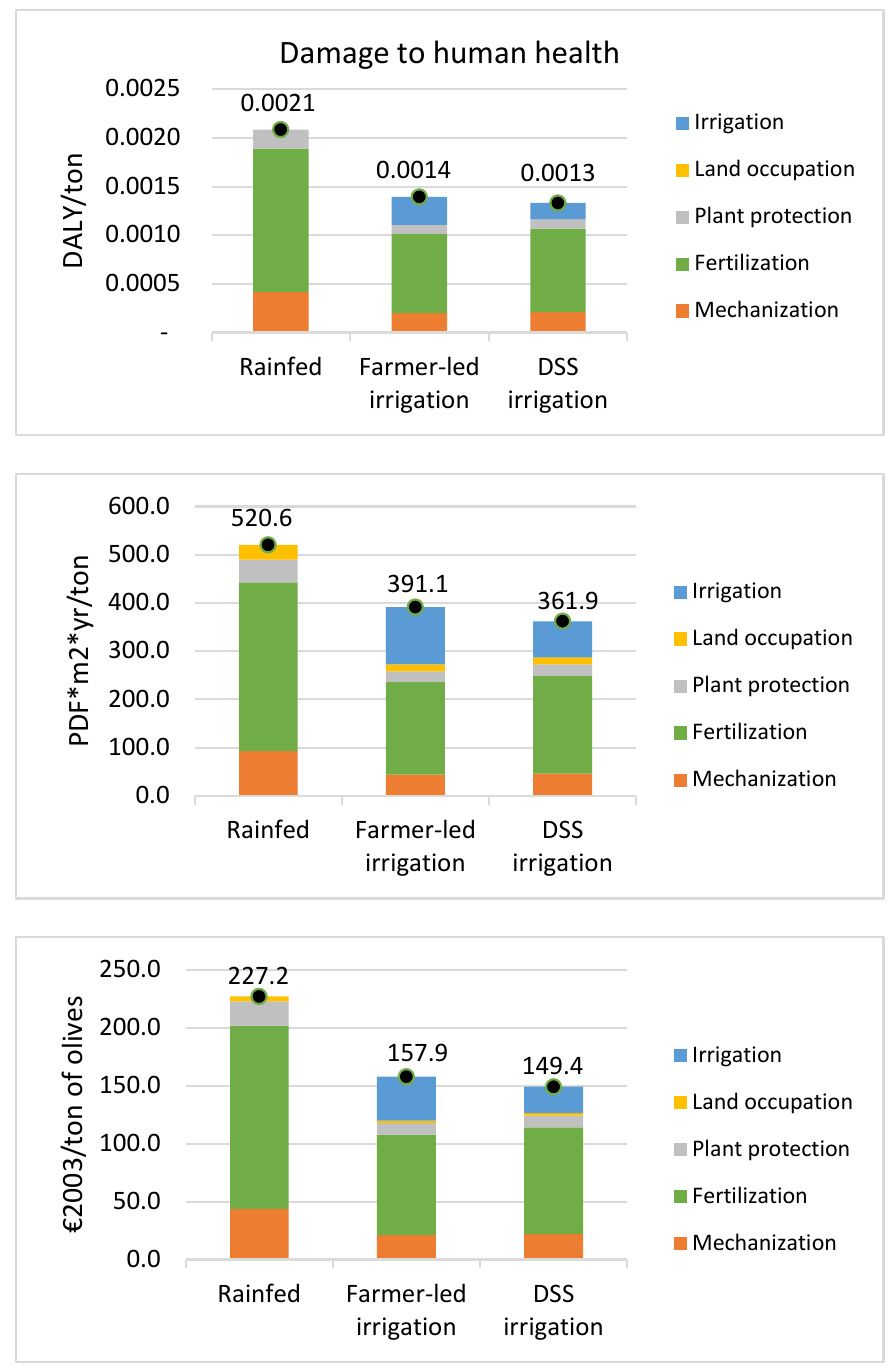
Figure 5. The human health, ecosystem, and overall environmental impact scores of olive cultivation under different management strategies.